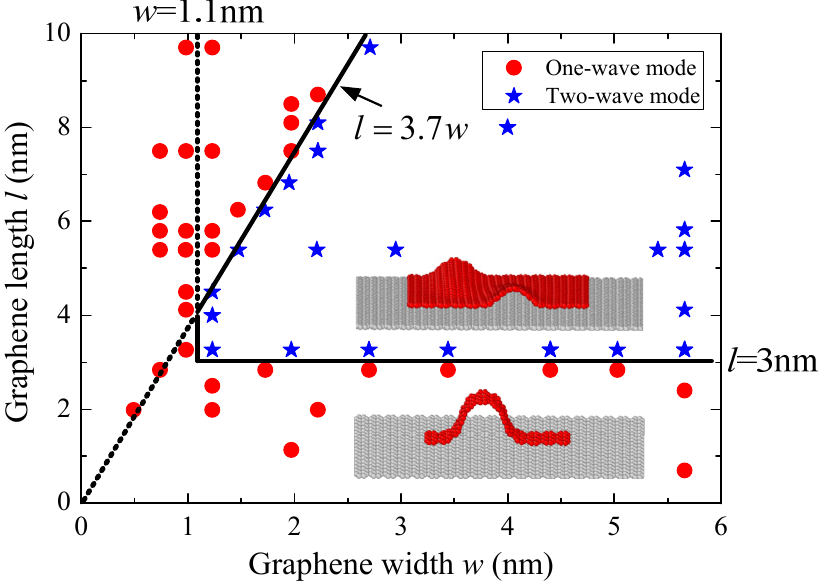
Figure 6. The buckling modes of monolayer graphene sheets with different sizes under uniaxial compression.